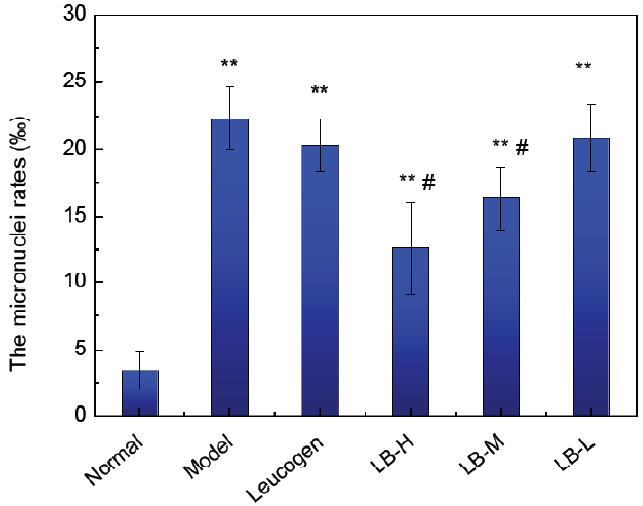
Figure 3. Effect of lingonberry anthocyanins on the development of micronuclei in bone marrow ( ** p < 0.01, * p < 0.05 vs. Normal; # p < 0.05 vs.